Question: Give a one-sentence summary of this figure.
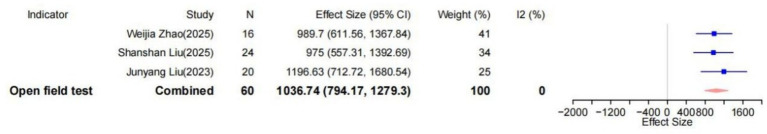
Answer: Open field test forest plot.